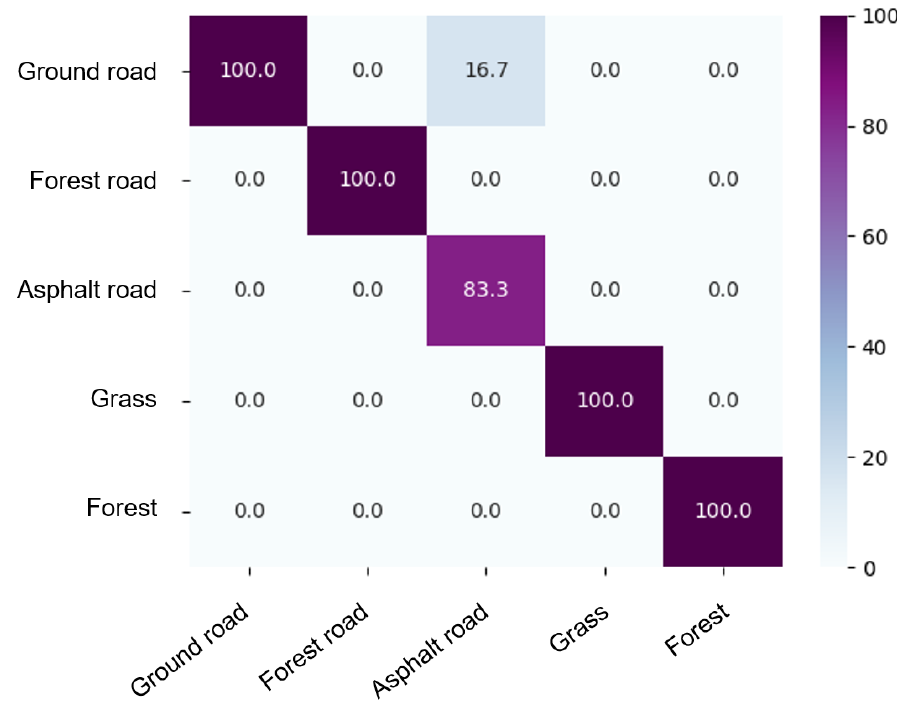
Figure 9. Confusion matrix for terrain classification matrix